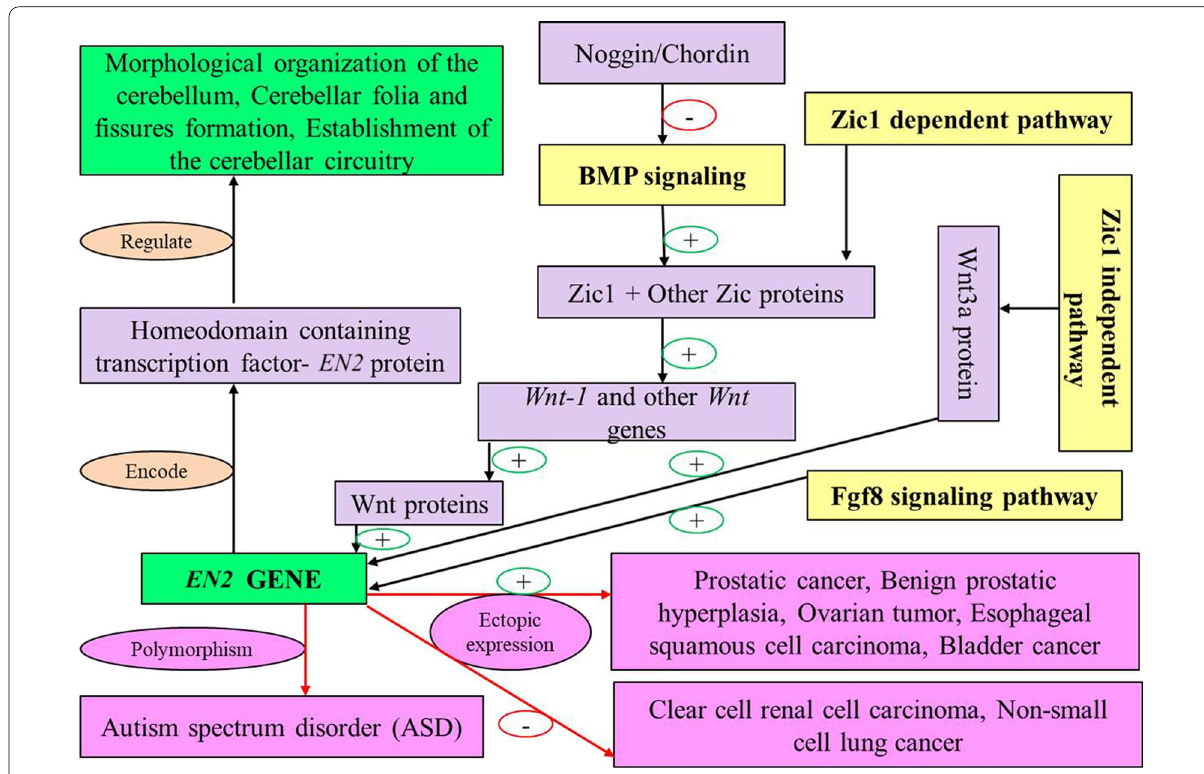
Fig. 2 Normal, ectopic and altered expressions of EN2 gene and